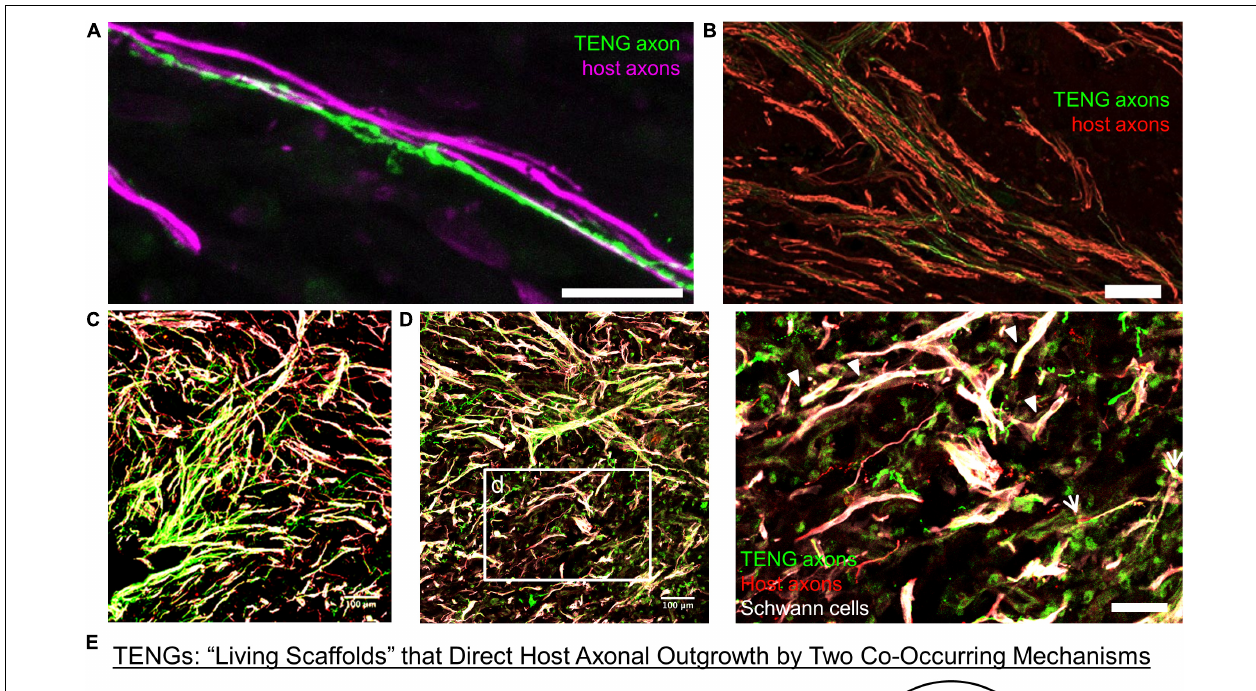
Frontiers in Bioengineering and Biotechnology |